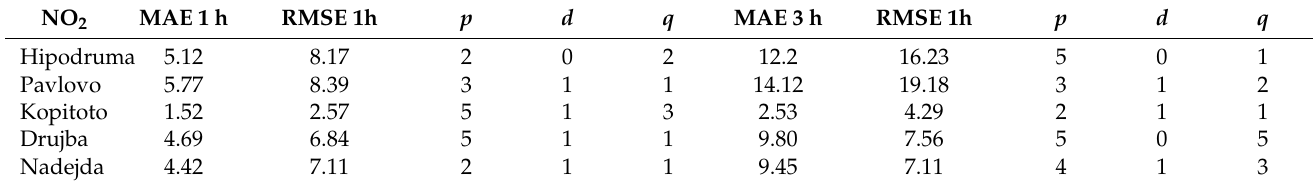
Figure 14. ARIMA model with predictions for NO 2 , 3 h granularity, based on grid search and ACF, PACF lags consideration. Table 10. Mean absolute error of NO 2 for the chosen parameters p, d, q, for 1 h and 3 h granularity.